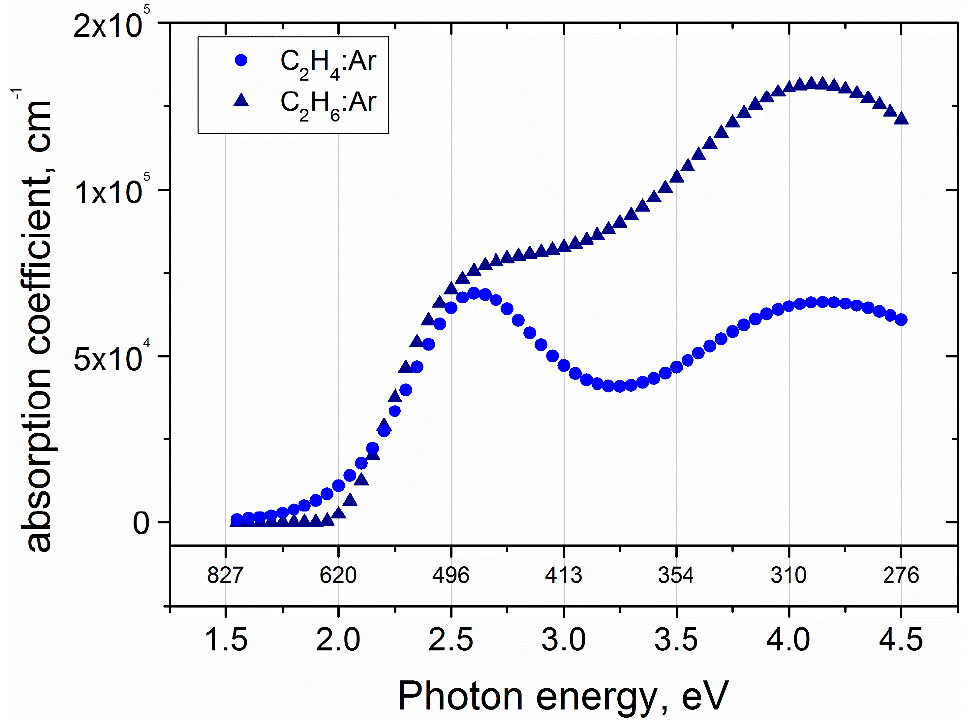
Figure 5. Absorption coefficients for the films prepared with C 2 H 4 /Ar and C 2 H 6 /Ar gas mixtures obtained from spectroscopic ellipsometry.